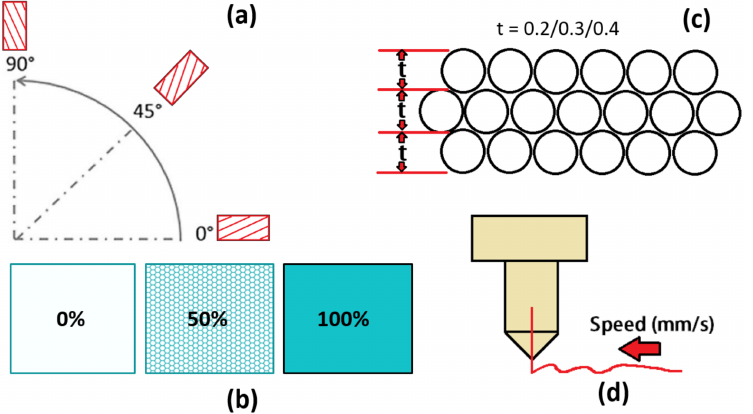
Figure 4. Printing parameter ( a ) orientation ( b ) infill density percentage ( c ) layer thickness and ( d ) printing speed.